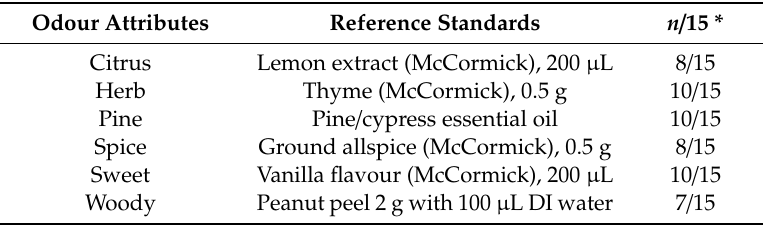
Table 1. Attributes and references used in evaluating in 6 essential oil